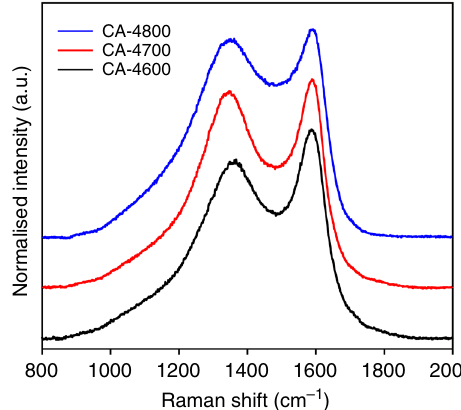
Fig. 1 Raman spectra of activated carbons prepared from cellulose acetate. The activated carbons are labelled as CA-4T, where 4 is the activation KOH/carbon ratio and T is the activation temperature